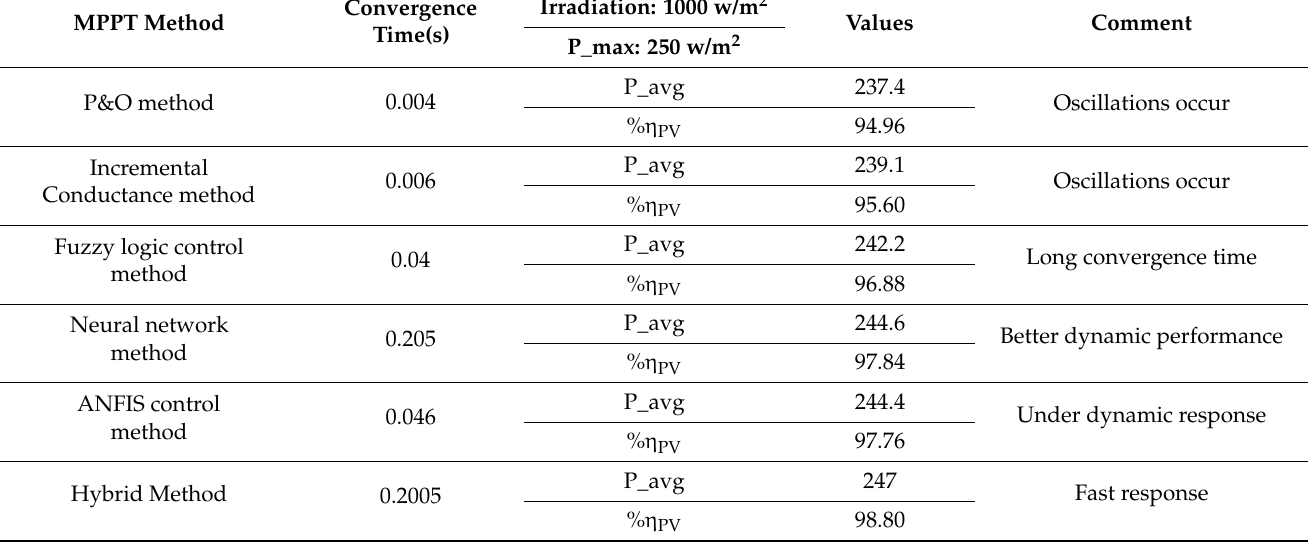
Table 6. Average power, convergence time, and efficiencies for various